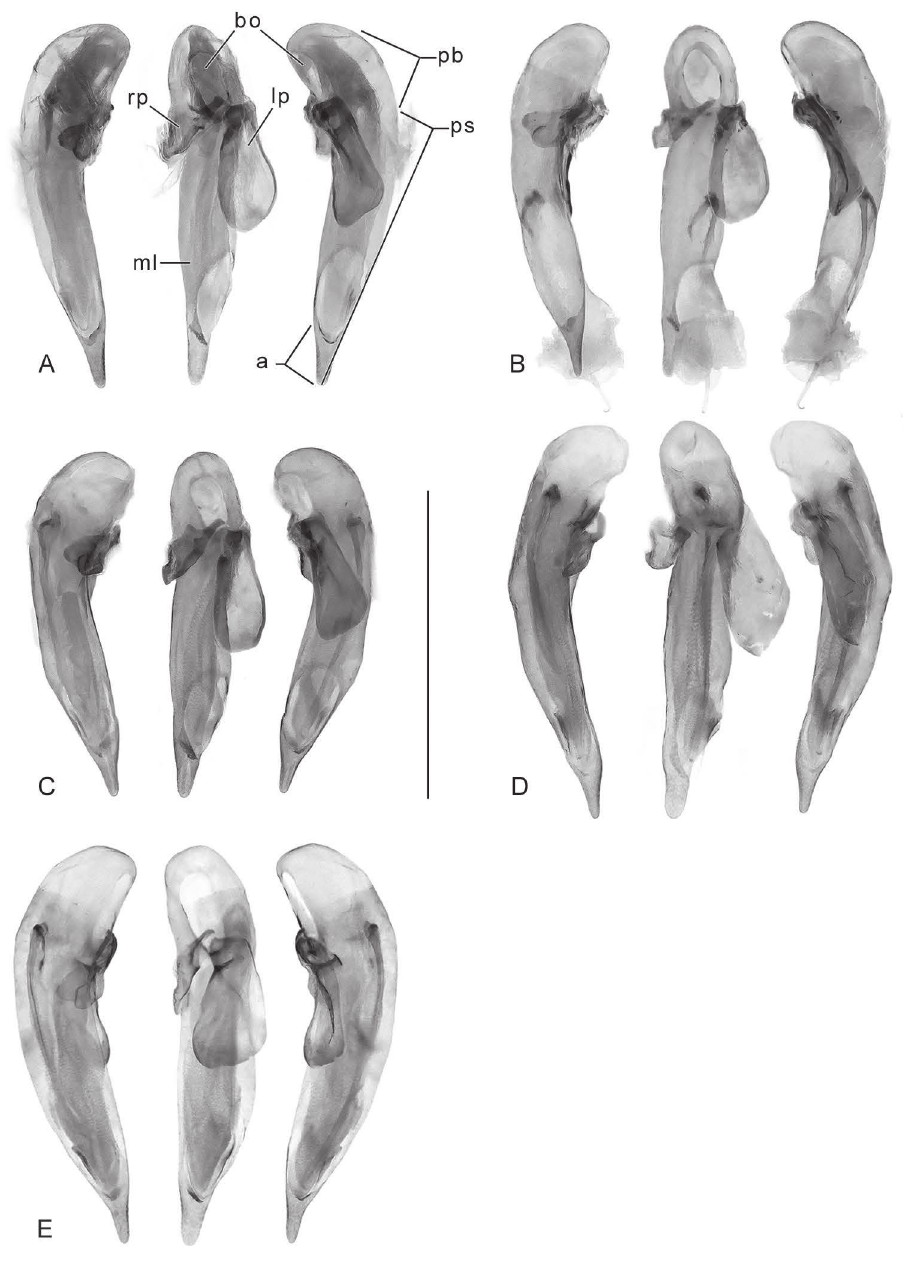
Figure 5. Digital Photo-illustration, male aedeagus in repose, dorsal, ventral, left lateral aspects. A Hyboptera angulicollis Chaudoir, ADP007330 B Hyboptera biolat Erwin & Henry, sp. n., ADP007443 C Hyboptera vestiverdis Henry & Erwin, sp. n., ADP014856 D Hyboptera tiputini Erwin & Henry, sp. n., ADP135845 E Hyboptera viridivittis Chaudoir, ADP007601. Legend, lp, left paramere; rp, right para- mere; pb, phallobase; bo, phallobase orifice; ps, phalloshaft; a, phalloapex. Scale line = 0.25